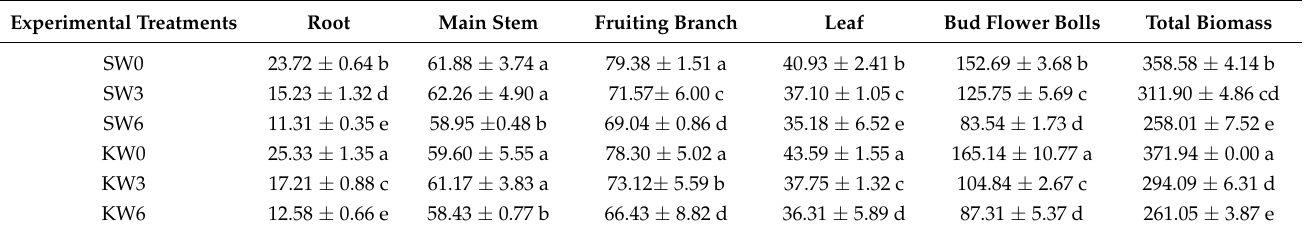
Table 1. Effect of potassium application on plant biomass in waterlogged cotton (g plant − 1 ).